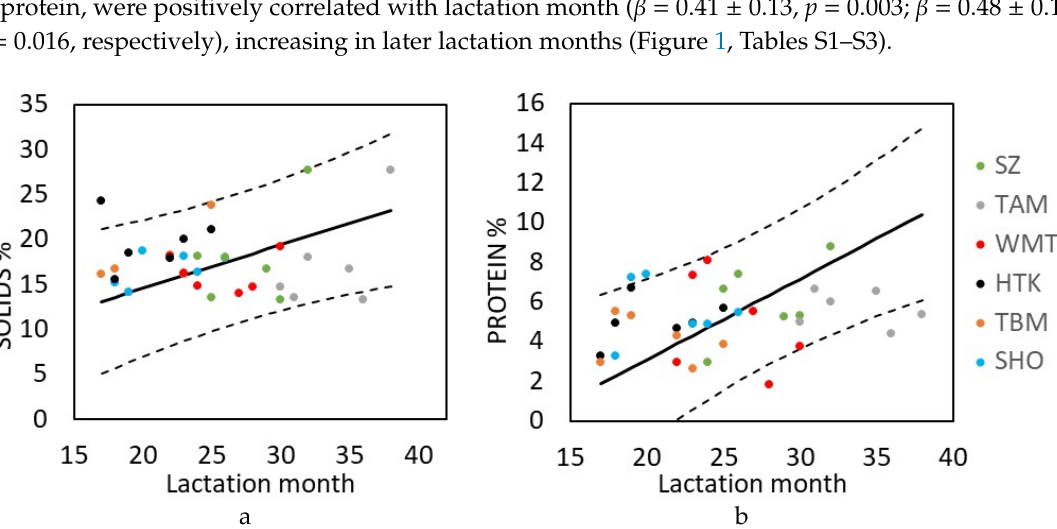
Figure 1. Variation in milk components with lactation month (calf age). Solids ( a ) and protein components ( b ) increased in later lactation months during late lactation in females’ milk. Points represent raw data for different mothers and solid lines show predicted values from the model with CLs (dashed lines). Predicted values drawn from the model according to reference categories and captive-born mothers. SZ, TAM, WMT, HTK, TBM, SHO: Elephant names coded as initials of house names.